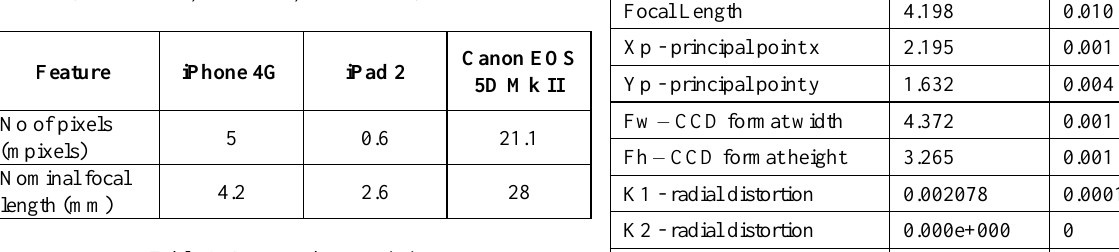
Table 1. Camera characteristics